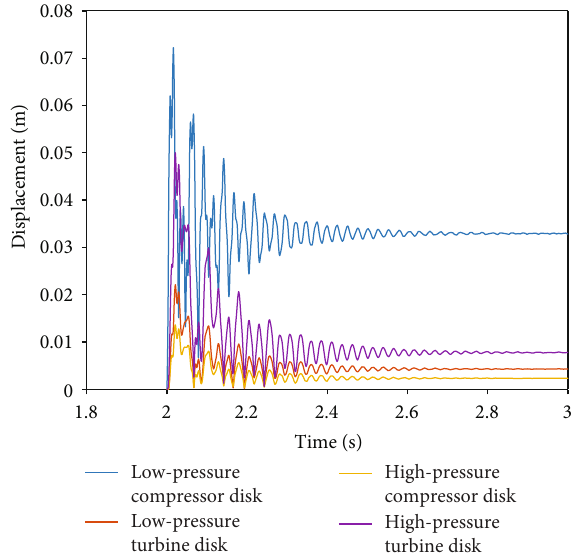
Figure 10: Reaction force of a dual-rotor system. Table 4: Reaction force of support